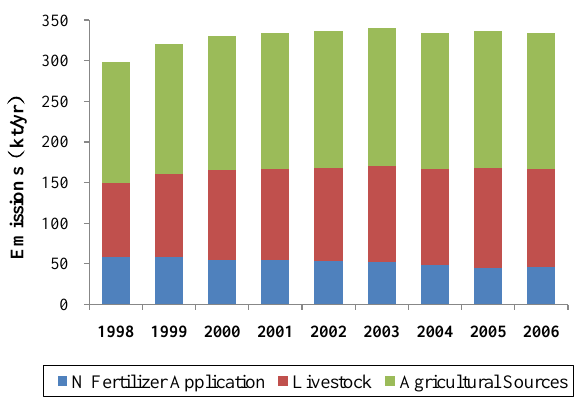
Fig. 9. NH 3 emissions from the categorical and total agricultural sources in the PRD region from 1998 to 2006.